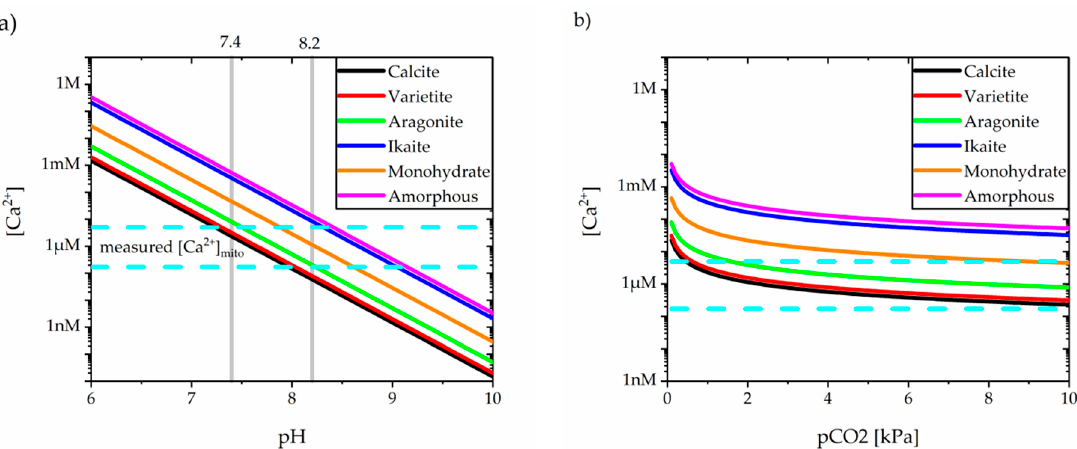
Figure 2. The calculated equilibrium concentrations of free calcium ( a ) as functions of pH at 37 °C and pCO 2 = 7 kPa, ( b ) as a function of partial pressure of carbon dioxide at 37 °C and pH = 7.8.